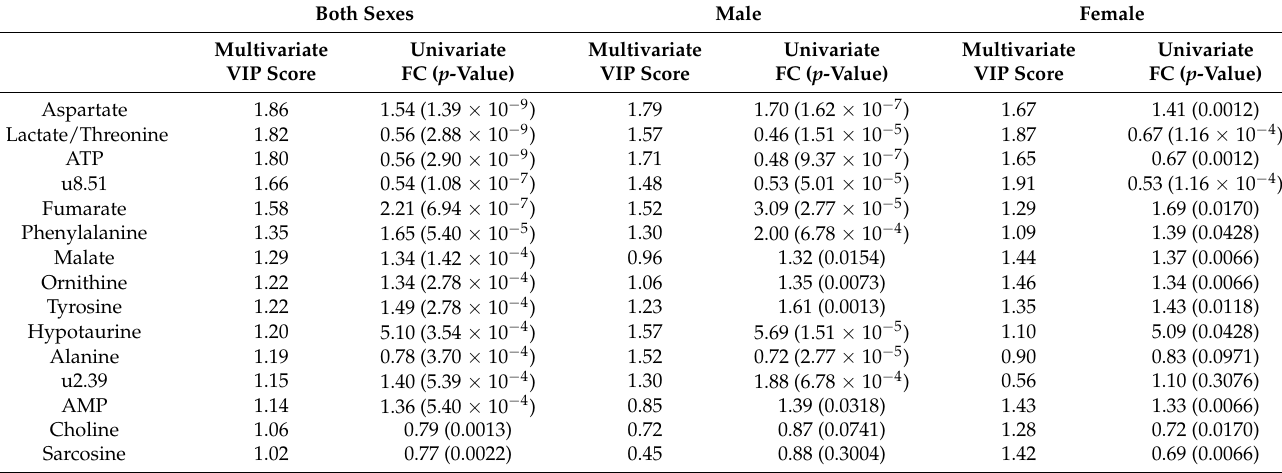
Table 1. Top 15 metabolites contributing to the variance between HO5 and iCab according to PLS ‐ DA and FC analysis. Analyses were performed separately for male and female fish, as well as with both sexes together. Only metabolite buckets are shown that had VIP values > 1.2 and FC > 1.3 or <0.77 for at least one of the different groups. For each FC, the associated FDR ‐ adjusted p ‐ value is shown.